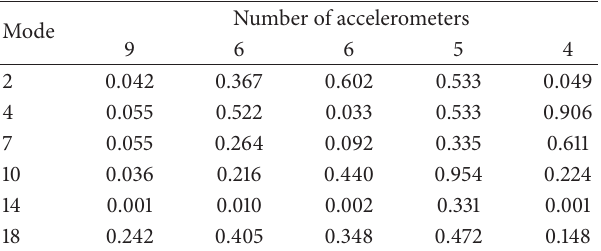
Table 7: The MAC values of acceleration damage parameter in X transitional direction.